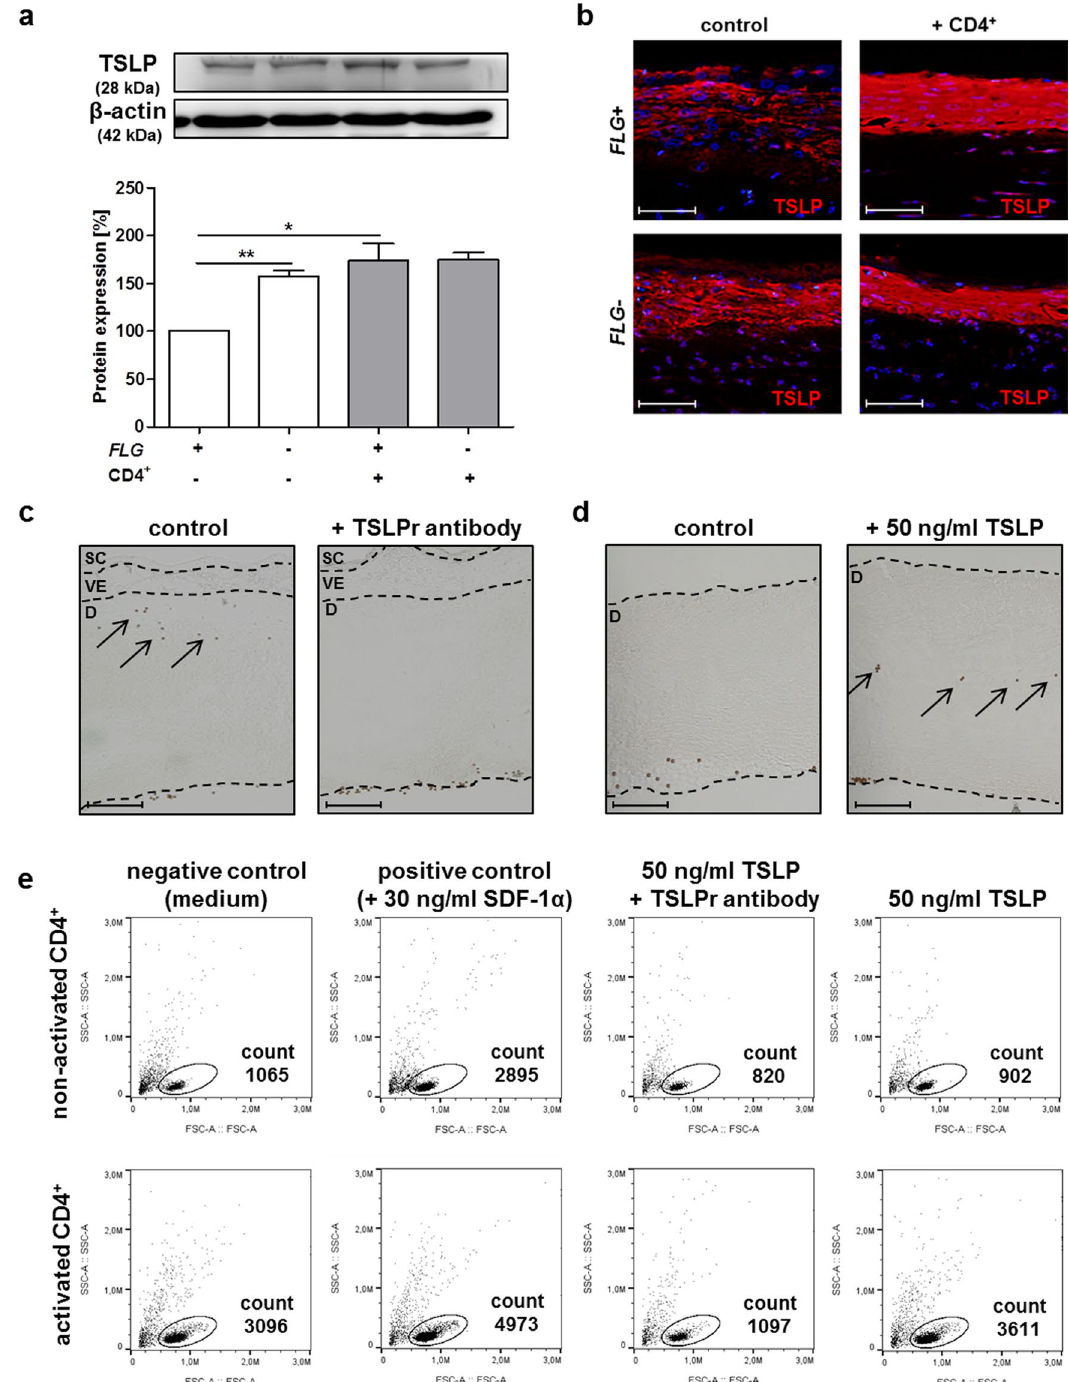
Figure 5. TSLP directly stimulates T cell migration in filaggrin-deficient ( FLG − ) skin equivalents. ( a ) Western blot and relative protein expression of TSLP in normal ( FLG + ) and FLG − skin equivalents before and after exposure to activated CD4 + T cells (mean ± SEM; n = 4), * indicates statistical significance over FLG + skin equivalents ( * p ≤ 0.05, ** p ≤ 0.01). ( b ) Representative immunostains against TSLP (red) in FLG + and FLG − skin equivalents (scale bar = 100 μ m). ( c ) Representative light microscopy pictures of FLG − skin equivalents supplemented with activated CD4 + T cells (control) and with TSLPr antibody pre-incubated T cells ( + TSLPr), scale bar = 100 µ m. ( d ) Dermis equivalents, with and without topical application of 50 ng/ml TSLP, prior to T cell exposure (scale bar = 100 µ m). ( e ) Representative dot plots from the flow cytometric transwell migration assay with non-activated and activated CD4 + T cells, incubated for 48 h with medium only (negative control), 30 ng/ml SDF-1 α (positive control), and 50 ng/ml TSLP with and without pre-incubation with TSLPr